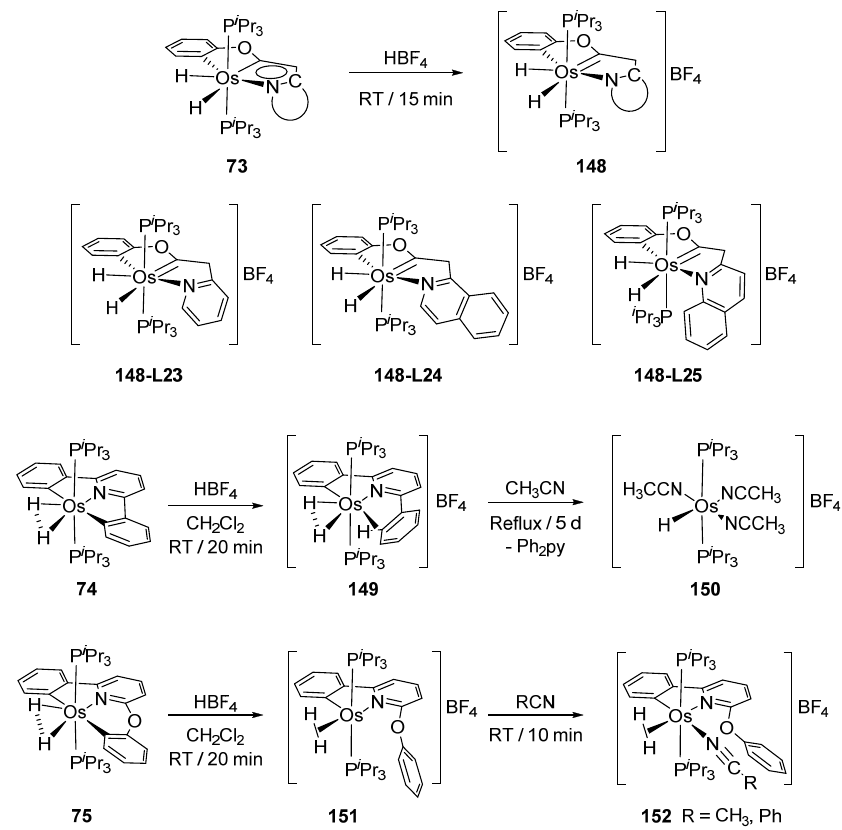
Figure 32. Protonation of the cyclometalated fragment by HBF 4